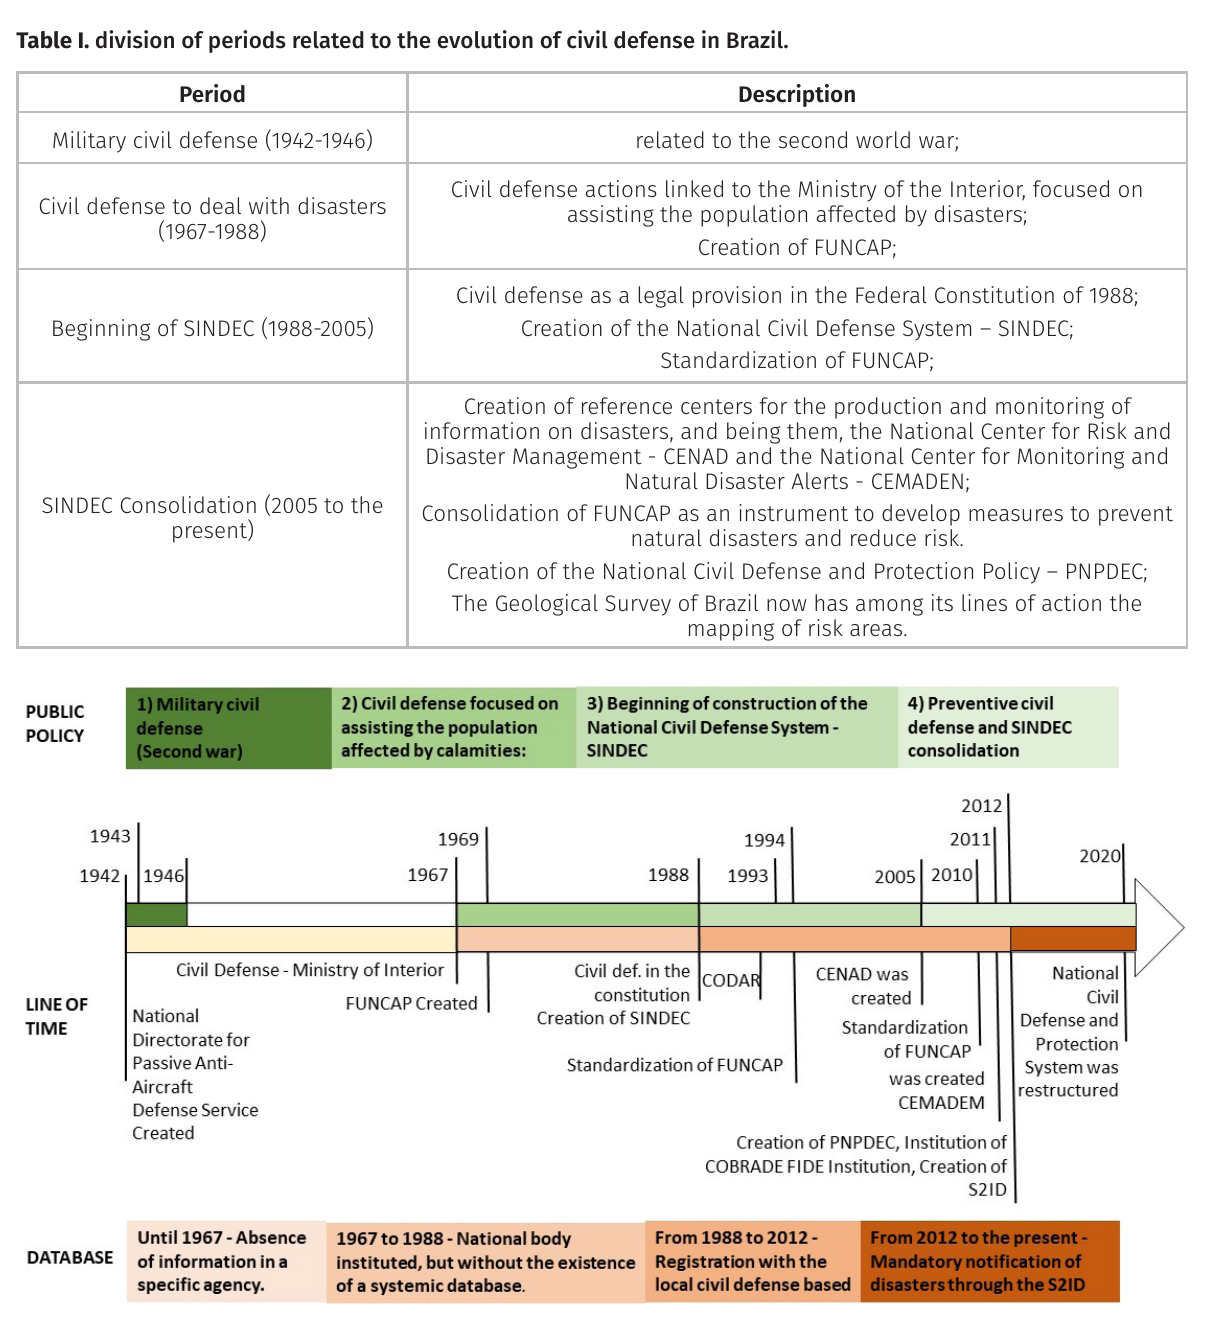
Figure 1. Schematic model of the evolution of civil defense as public policy and the evolution of the record on natural disasters in Brazil (prepared by the